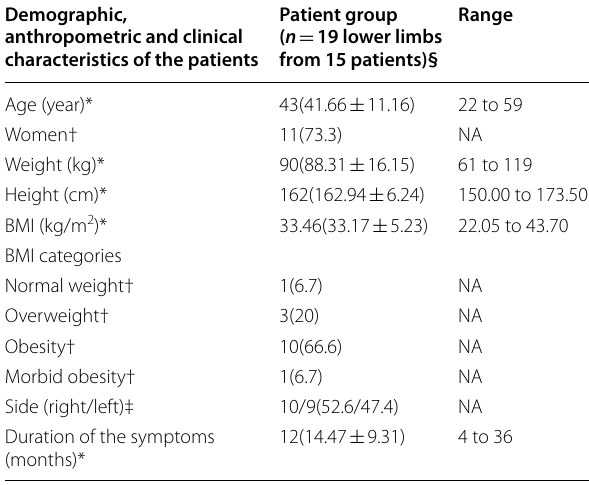
anthropometric and clinical characteristics of the